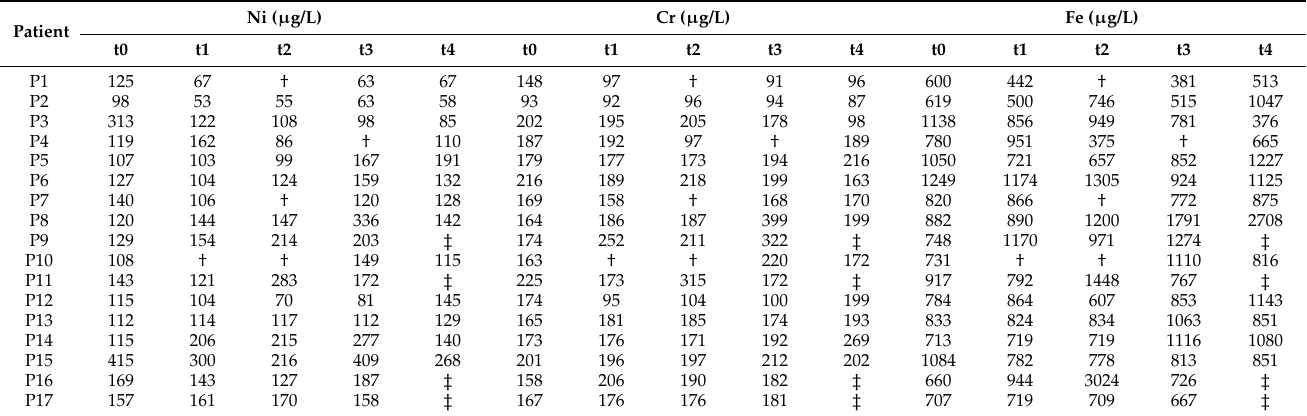
Table 3. Inductively coupled plasma optical emission spectroscopy (ICP-OES) ion concentrations of the 17 patients at the five time intervals: prior to treatment (t0) and after 2 days (t1), 1 week (t2), 4 weeks (t3), and 12 weeks